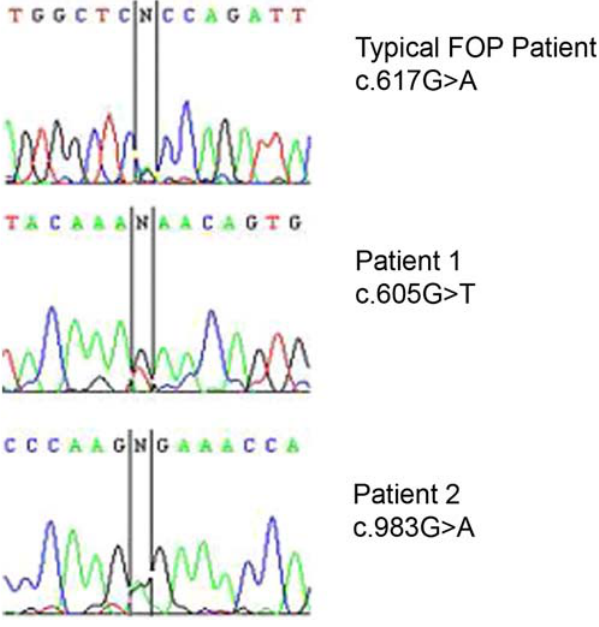
Figure 1. DNA sequencing electropherograms of a typical FOP patient, and of atypical patients 1 and 2, at the positions of the causative ACVR1 mutations.